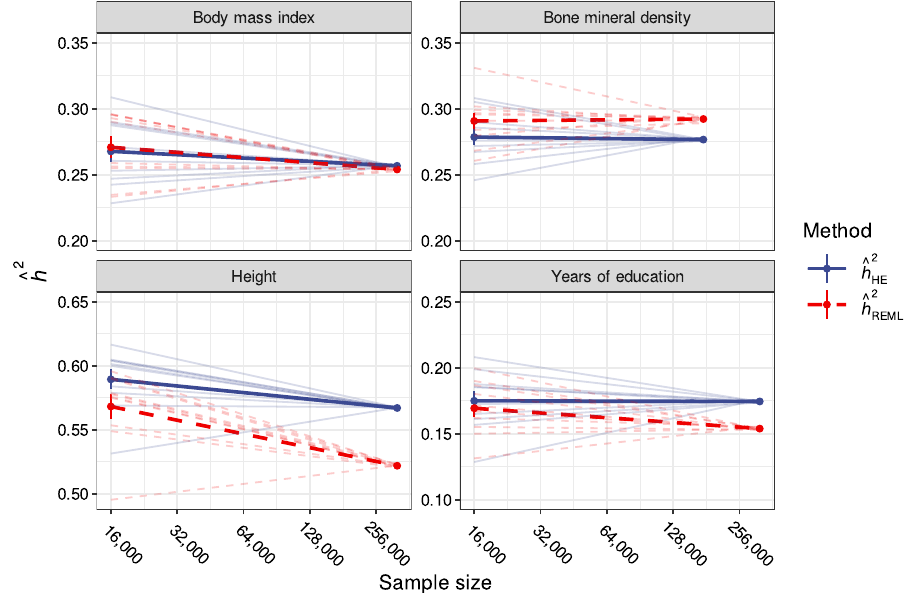
) and REML ( ^ h 2 ) heritability estimates as a HE REML